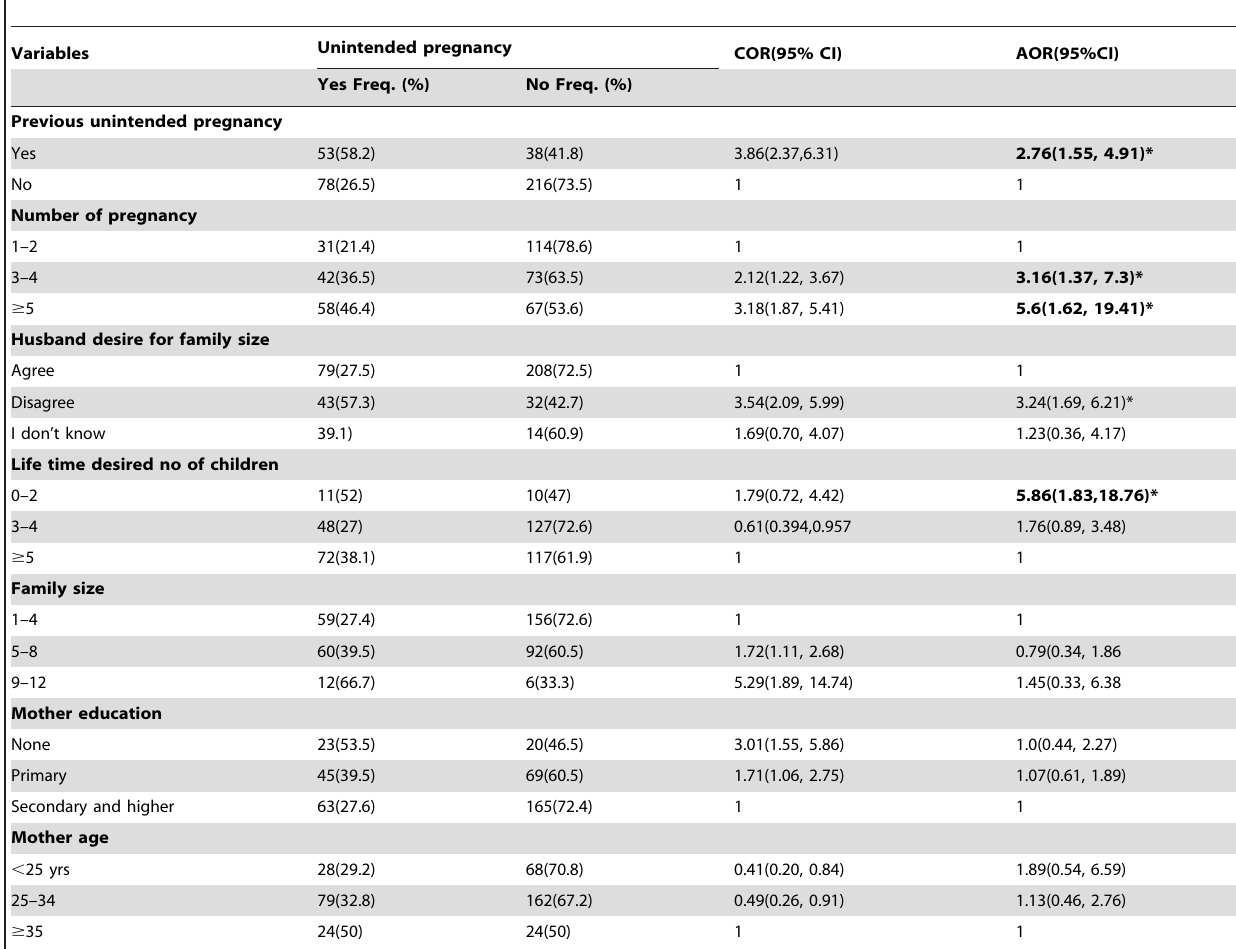
Table 4. Association of Reproductive and Socio-Demographic Characteristics of Pregnant Married Women with Unintended Pregnancy, Hossana Town, SNNP, April